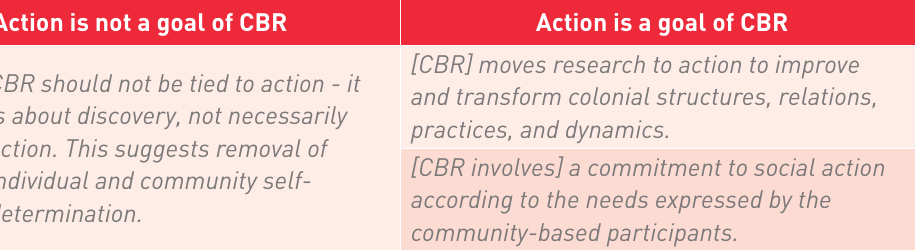
Divergent perspectives on action as a goal of